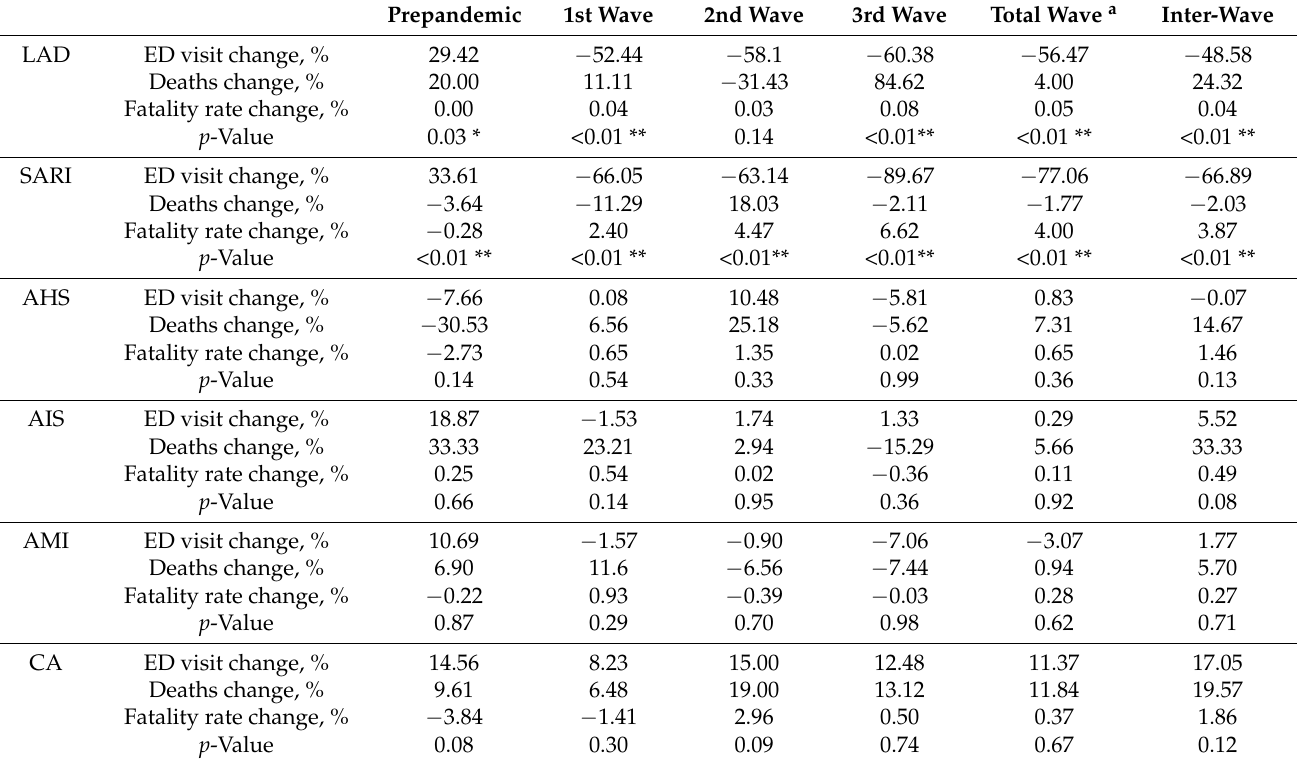
Table 2. Comparison between epidemic wave in COVID-19 pandemic and control